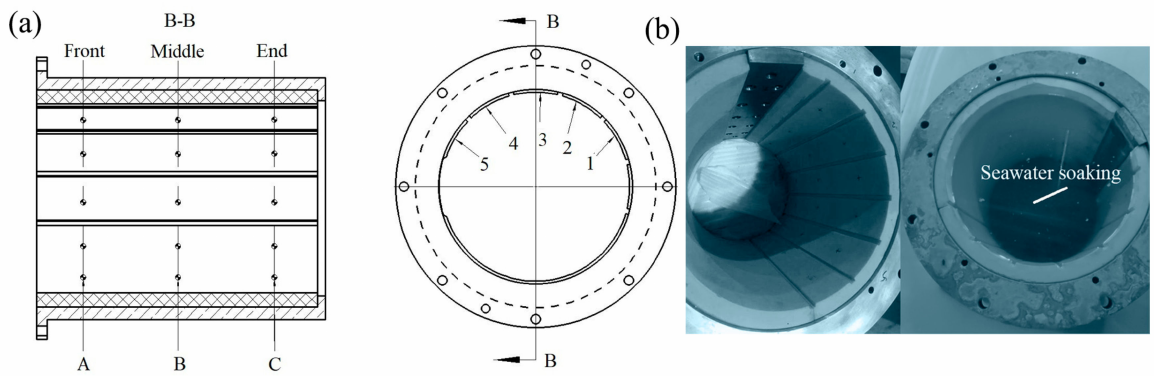
Figure 5. ( a ) Measuring point position of bearing diameter, ( b ) bearing pictures before and after soaking.